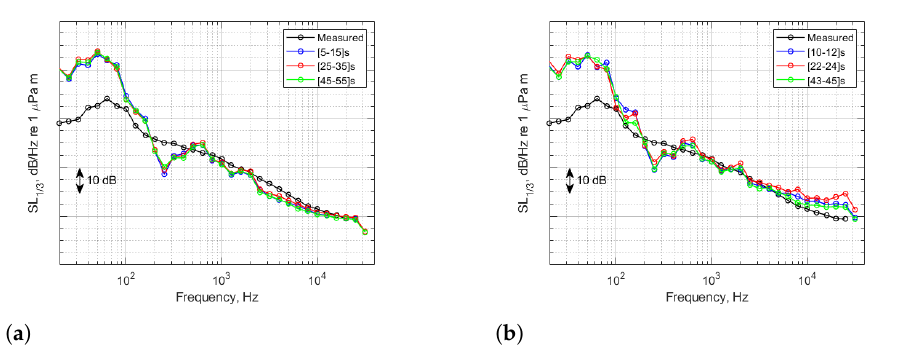
Figure 23. Comparison of the source levels estimated for different recording times: ( a ) 10 s